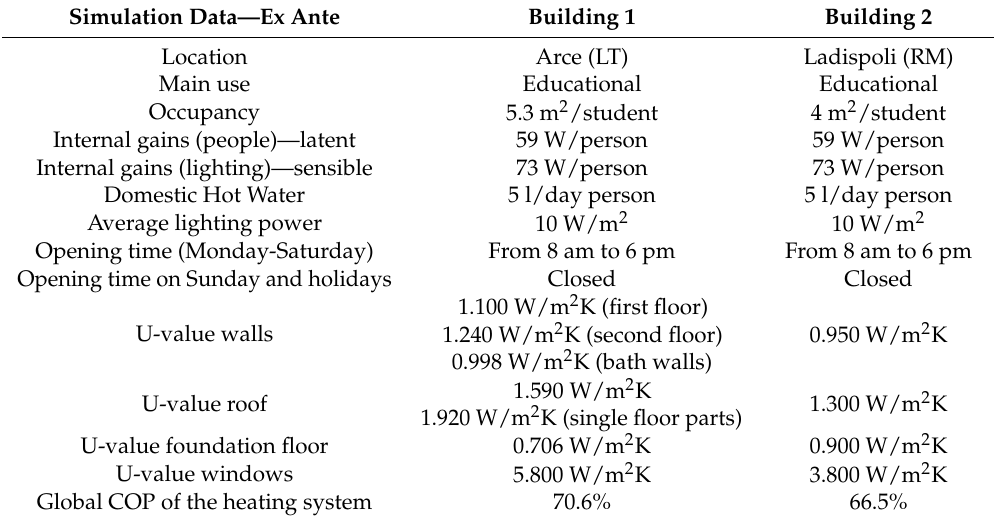
Table 6. Buildings model data set before retrofit.